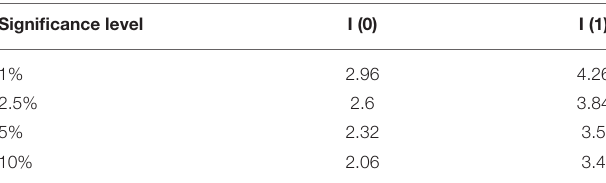
TABLE 5 | ARDL bound